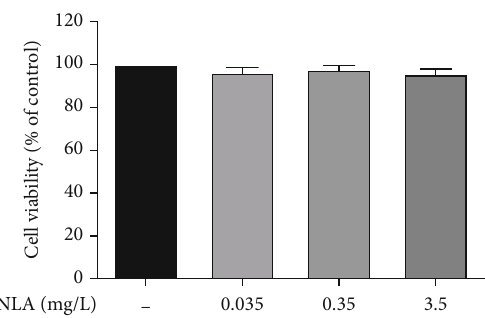
Figure 1: E ff ect of DNLA on cell viability in PC12 cells. The cell viability in PC12 cells after treatment with DNLA ( n = 6 , (cid:1) x ± s ).